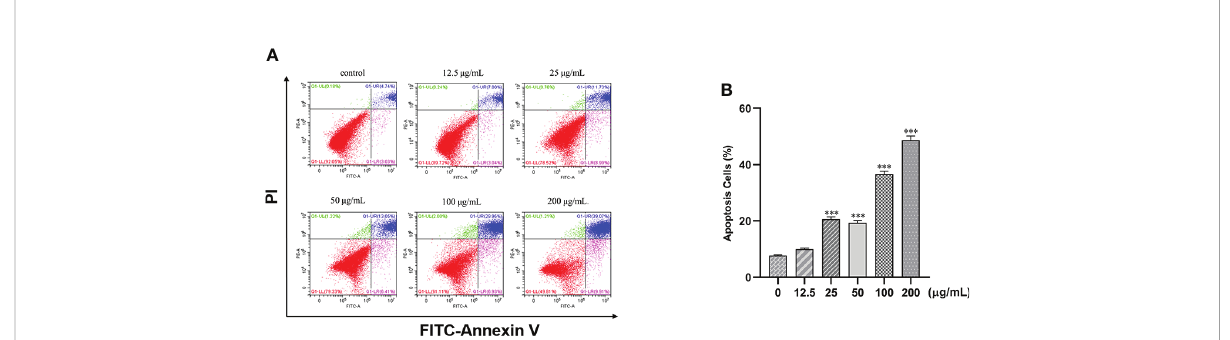
FIGURE 7 Effects of 1,2,3,4,6-pentagalloyl- b -D-glucose on the apoptosis of SGC7901 cells. (A) FITC-Annexin V/PI double-staining fl ow cytometry showing the apoptosis rate of SGC7901 cells after treatment with 1,2,3,4,6-pentagalloyl- b -D-glucose and 5-FU (0, 12.5, 25, 50, 100, and 200 µg/ml) for 48 h (B) Average apoptosis rate of SGC7901 cells. *** p < 0.001 vs. 0